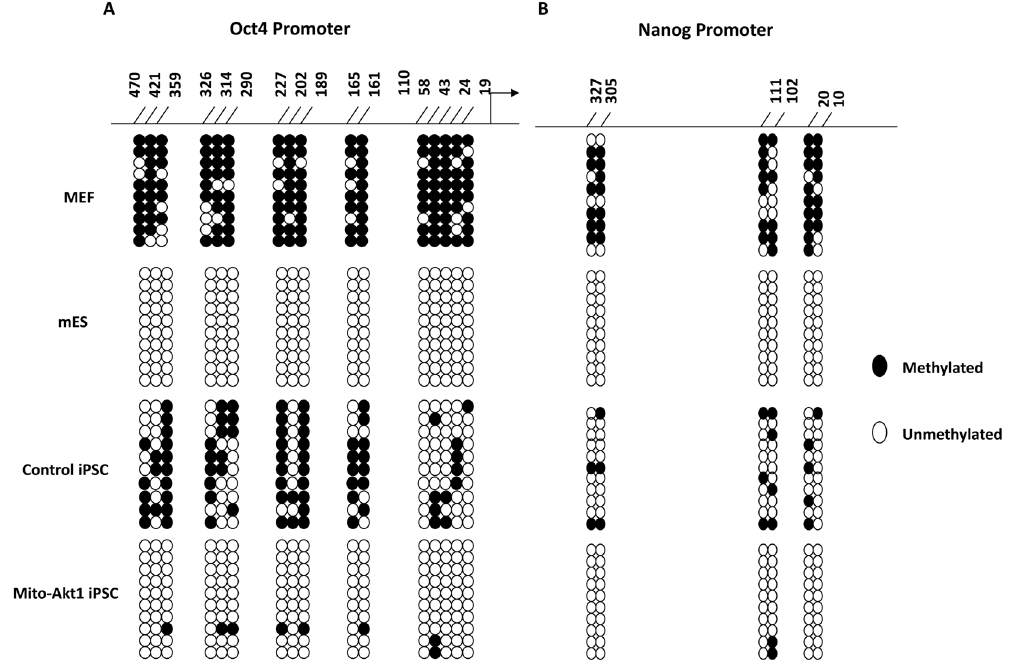
Figure 4. Methylation of Oct4 and Nanog promoters in mouse iPSCs. ( A ) Bisulfite sequencing of the promoter region of Oct4. ( B ) Bisulfite sequencing of the promoter region of Nanog. Genomic DNA were extracted from MEF, mouse ESC and iPSCs for bisulfite sequencing to determine the methylation status of the CpG islets at Oct4 and Nanog promoters. 10 random colonies from each group were used for this